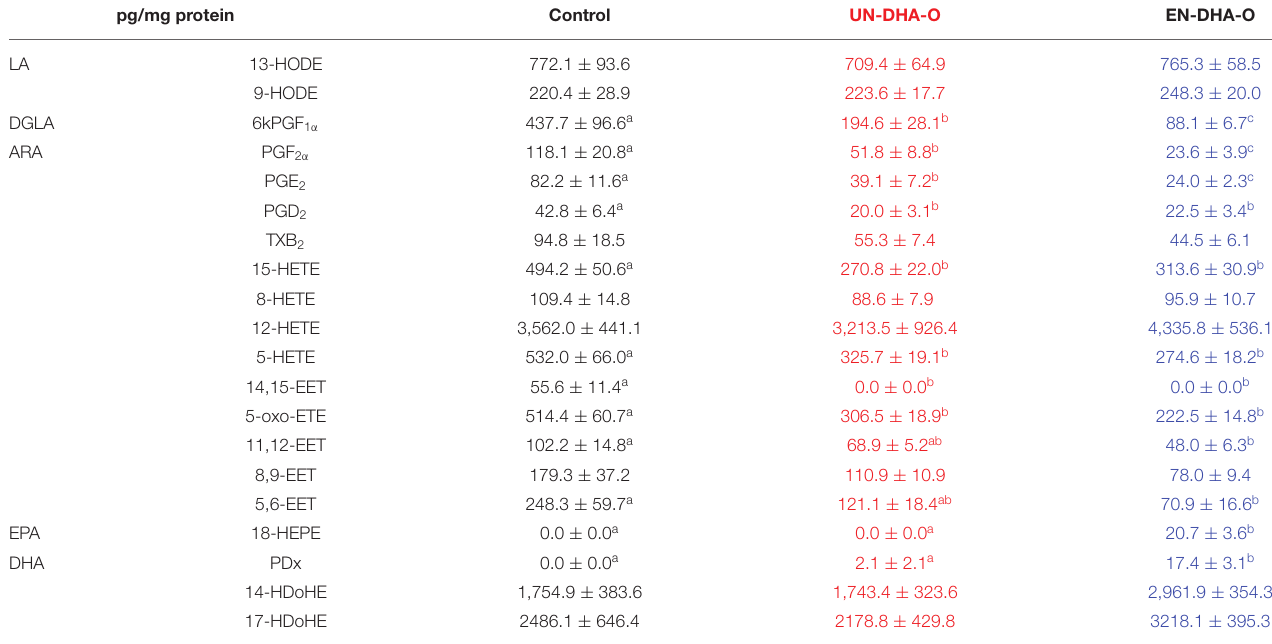
TABLE 7 | The oxidized derivatives of fatty acids from heart. pg/mg